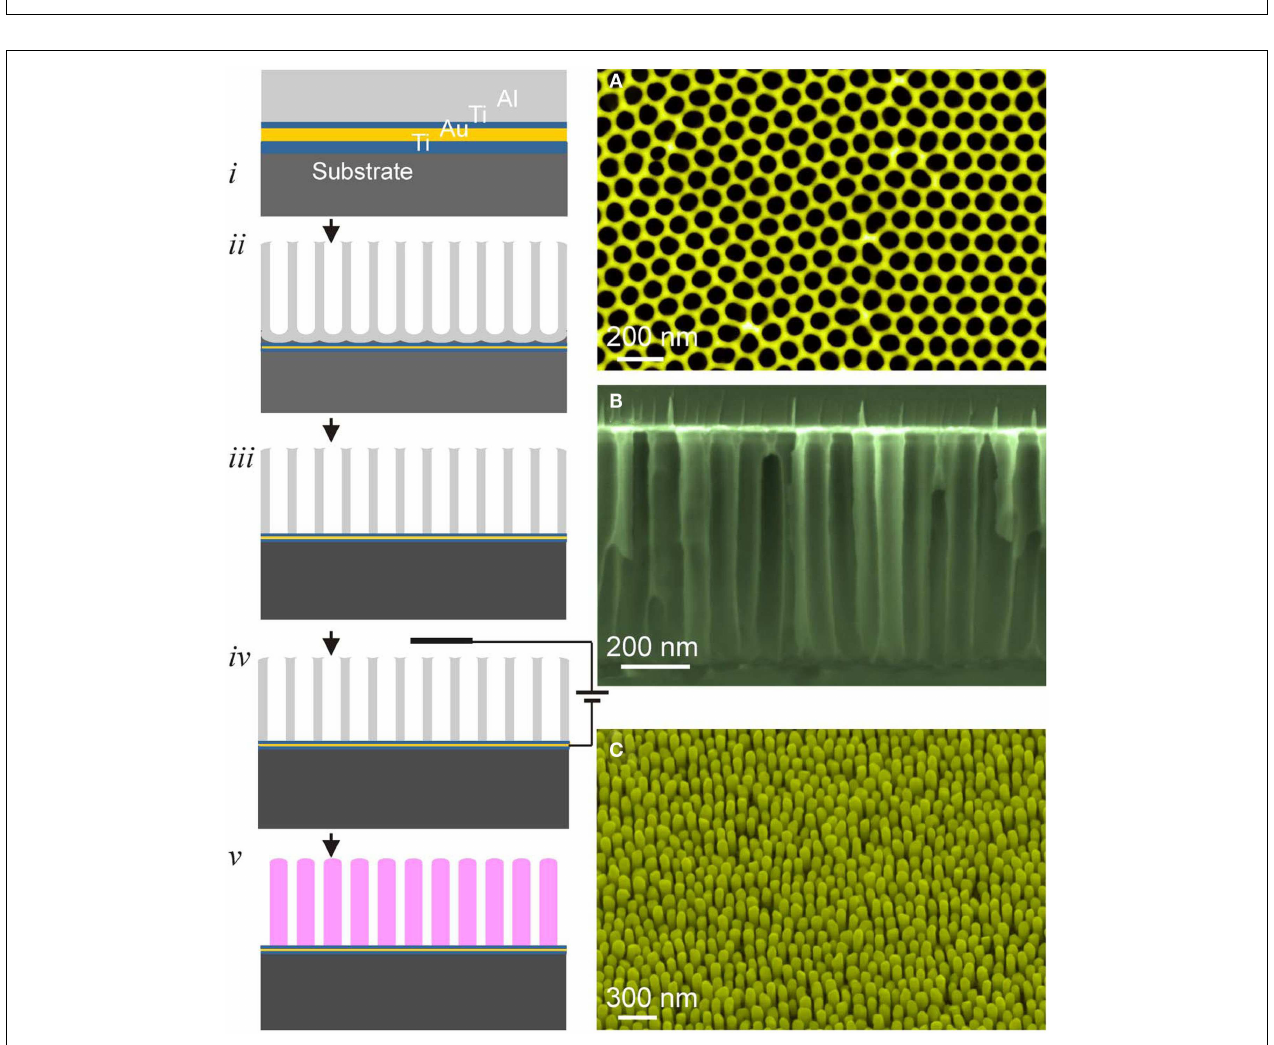
FIGURE 4 | Left: schematic illustration of the processing steps of PAAF: (i) film heterostructure, (ii) anodization, (iii) barrier-layer opening, (iv,v) electrodeposition and PAAF removal, exposing the nanostructure array . Right: (A) top view of a PAAF, (B) cross-section, and (C) on-substrate nanorods (Au-nanorods in this